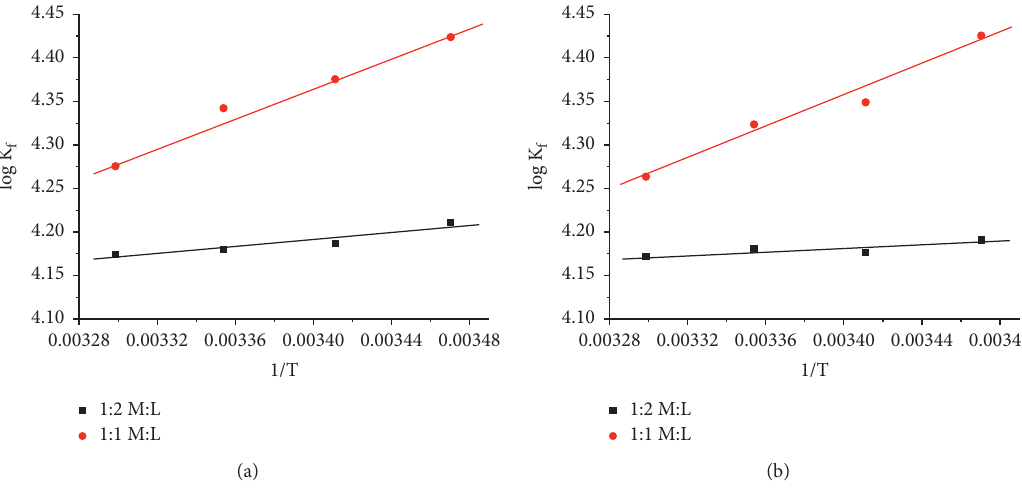
Figure 10: Variation of log K f with l/ T for (a) bulk Cu-CFT complex and (b) nano-Cu-CFT complex in distillate H 2 O. Table 9: Different formation parameters (Gibbs free energy of formation ( Δ G f ), enthalpy change ( Δ H f ), and entropy change ( Δ S f )) for bulk Cu-CFT complex in distillate H 2 O at different temperatures.